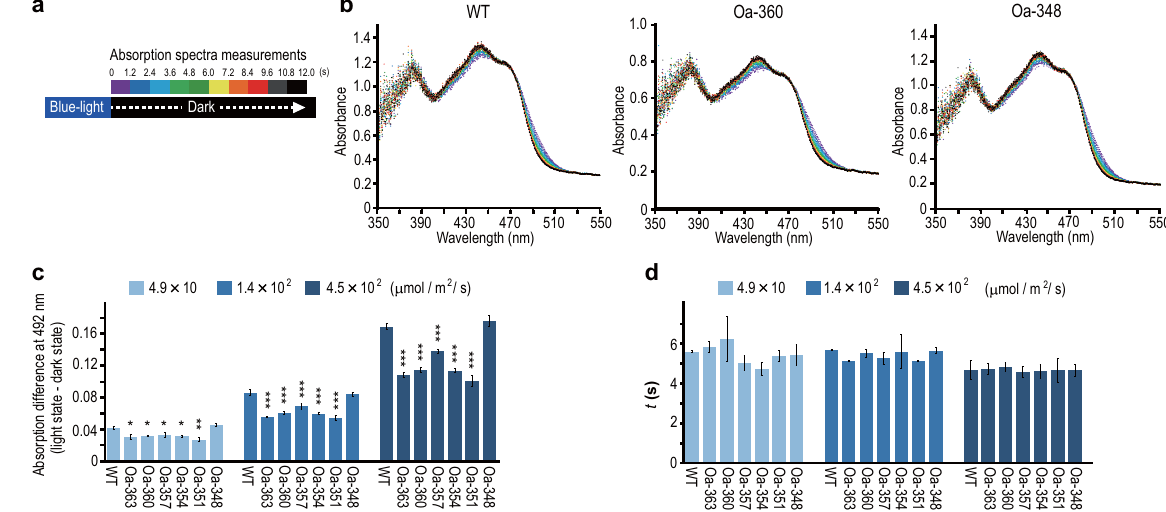
Figure 5. The C-terminal region did not influence the structural changes in the BLUF domain. Structural changes in the BLUF domain, depending on blue-light irradiation, were detected by recording the absorption spectra. ( a ) OaPAC WT and mutants were irradiated with blue light for 20 s, and immediately after, absorption spectra were recorded every 0.4 s. ( b ) Representative absorption spectra of the WT, Oa-360, and Oa-348 at irradiation intensity of 4.5 × 10 2 µ mol m − 2 s − 1 . Spectra after every 1.2 s are shown in the indicated color in ( a ). ( c ) Absorption differences between light-adapted states and dark-adapted states at 492 nm for each irradiated intensity. Bars indicate mean ± S.D. (n ≥ 3). Absorption differences were analyzed using one-way ANOVA (4.9 × 10 µ mol m − 2 s − 1 ; F (6, 14) = 14.008, P < 0.0001. 1.4 × 10 2 µ mol m − 2 s − 1 ; F (6, 17) = 42.151, P < 0.0001. 4.5 × 10 2 µ mol m − 2 s − 1 ; F (6, 43) = 279.281, P < 0.0001) followed by the Tukey–Kramer test ( * P < 0.05; ** P < 0.01; *** P < 0.0001 vs. WT). ( d ) Time constants of structural changes from light-adapted states to the dark- adapted states at 492 nm for each irradiated intensity. Bars indicate mean ± S.D. (n ≥ 3). The time constants of rates were analyzed using one-way ANOVA, and no statistically significant difference was found between the WT and mutants (4.9 × 10 µ mol m − 2 s − 1 ; F (6, 14) = 1.776, P = 0.176. 1.4 × 10 2 μ mol m − 2 s − 1 ; F (6, 17) = 1.103, P = 0.401. 4.5 × 10 2 µ mol m − 2 s − 1 ; F (6, 43) = 0.294, P =